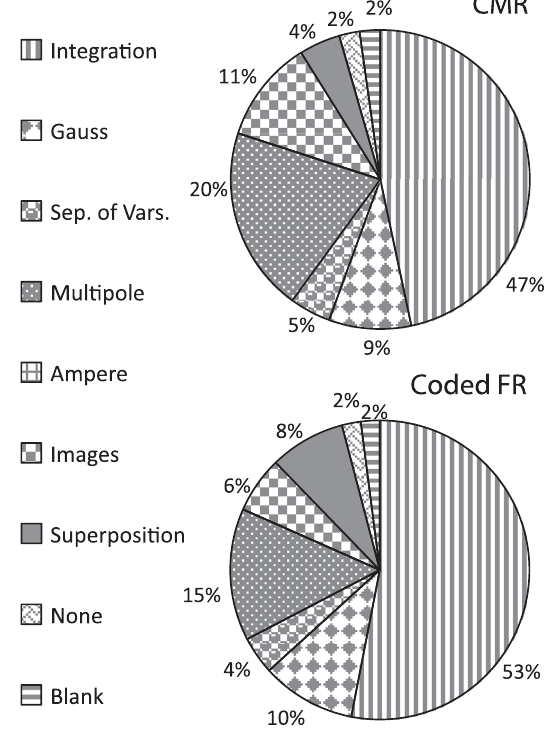
FIG. 5. Percent of students who selected each method on Q2 for each version of the CUE. The top chart represents student selections from the CMR version ( N ¼ 45 ), while the bottom chart represents coded method selections from the FR version ( N ¼ 49 ). The difference between the two distributions is not statistically significant (Fisher ’ s exact test, p > 0 . 05